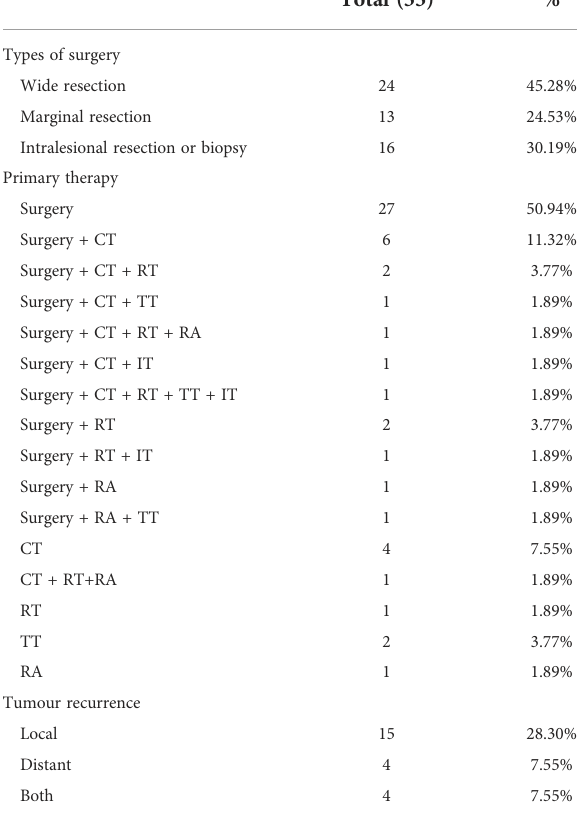
TABLE 2 Treatment and recurrence details of